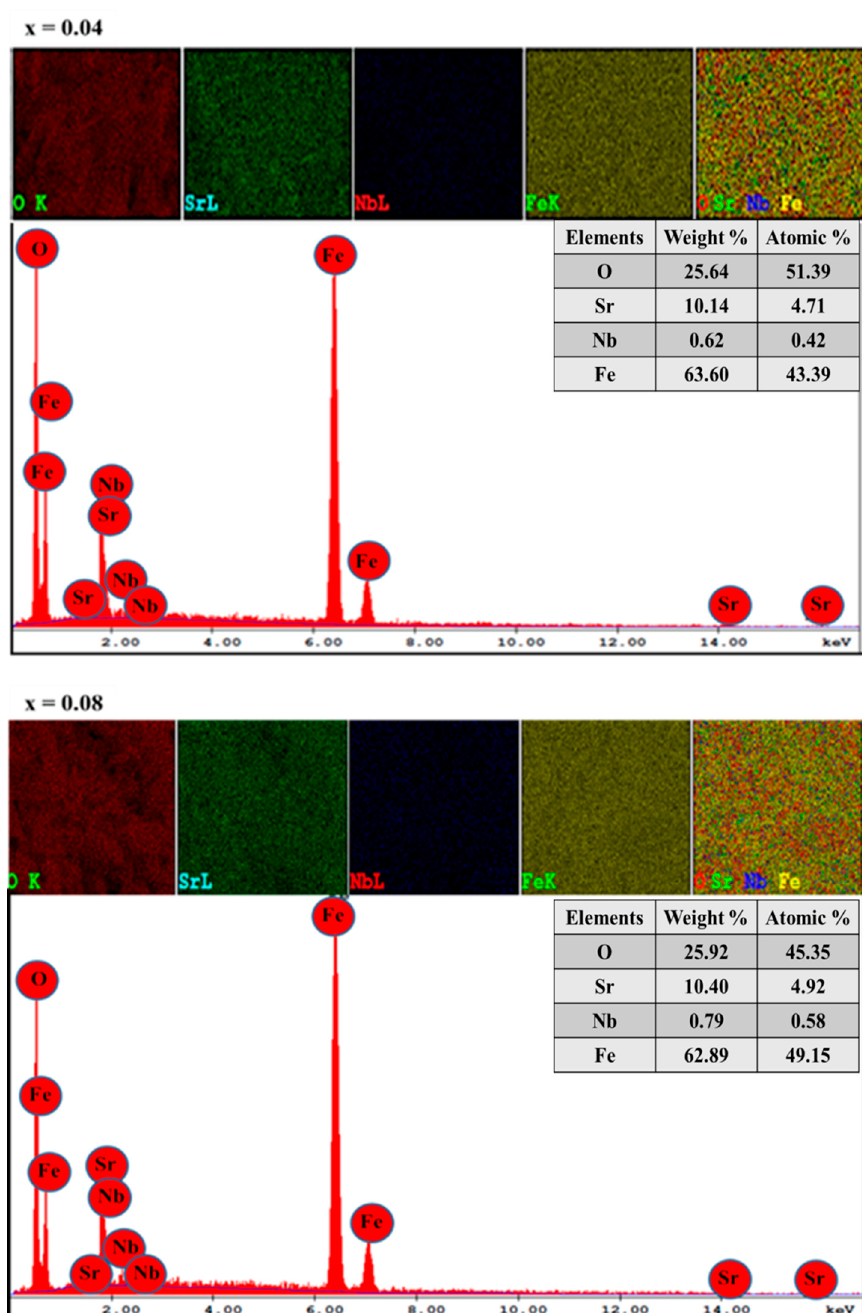
Figure 3. EDX patterns and elemental mapping results of SrNb 0.04 Fe 11.96 O 19 and SrNb 0.08 Fe 11.92 O 19 (0.00 ≤ x ≤ 0.08) HFs.